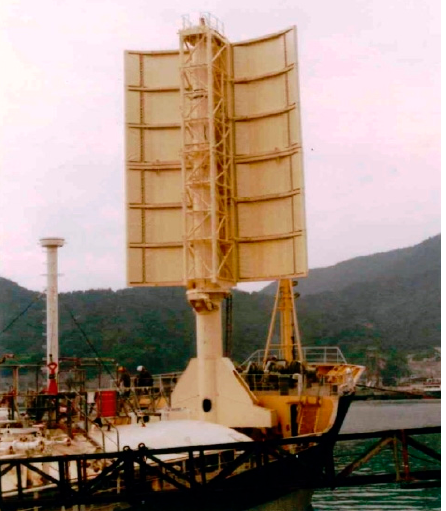
Figure 4. Japan Machinery Development Association (JAMDA) Rigid Sail at Teramoto Iron Works in the 1980’s [47].